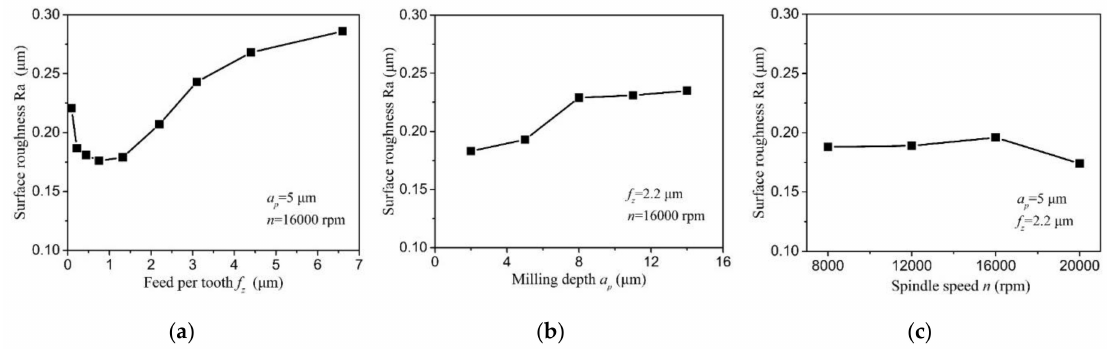
Figure 12. The surface roughness curve varies with milling parameters: ( a ) surface roughness versus feed per tooth, ( b ) surface roughness versus depth of cut, ( c ) surface roughness versus spindle